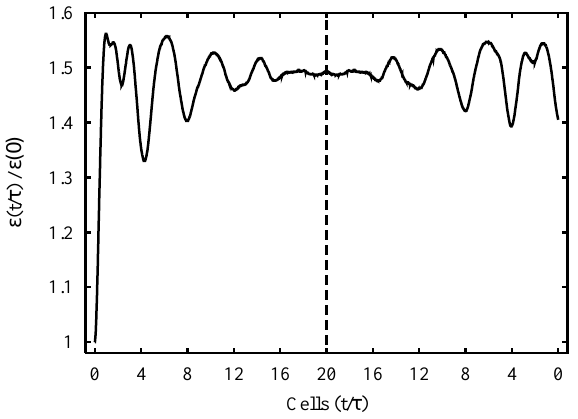
FIG. 4. Emittance growth factors versus the number of cells obtained by 3D simulations of a periodic nonisotropic focusing system at s 0 (cid:1) 60 ± , s (cid:1) 15 ± per cell, 2000 simulation particles. After 100 cells the time reversal